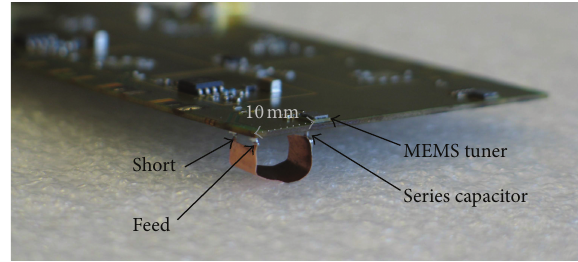
Figure 6: High-band demonstrator.